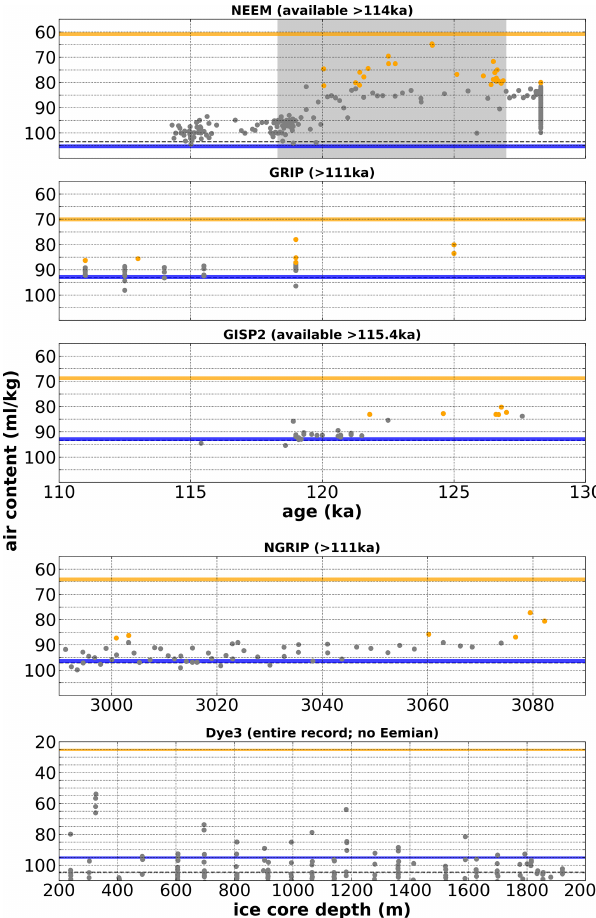
Figure 7. Observed TAC from five Greenland ice cores – NEEM, GRIP, GISP2, NGRIP, and Dye-3. Observations (circles) are com- pared with mean simulated TAC for 115ka (blue lines) and 125ka simulations (orange lines). Furthermore, data points used to cal- culate the Eemian range in Fig. 6 (orange circles) and the model- derived TAC before reducing it by the refreezing percentage (dashed lines; see Sect. 2) are shown. Note that NEEM, GRIP, and GISP2 are shown against age (robust age models), while NGRIP and Dye- 3 are shown against ice core depth. The NEEM melt zone (NEEM community members, 2013) is highlighted with a gray shading. The y axes are